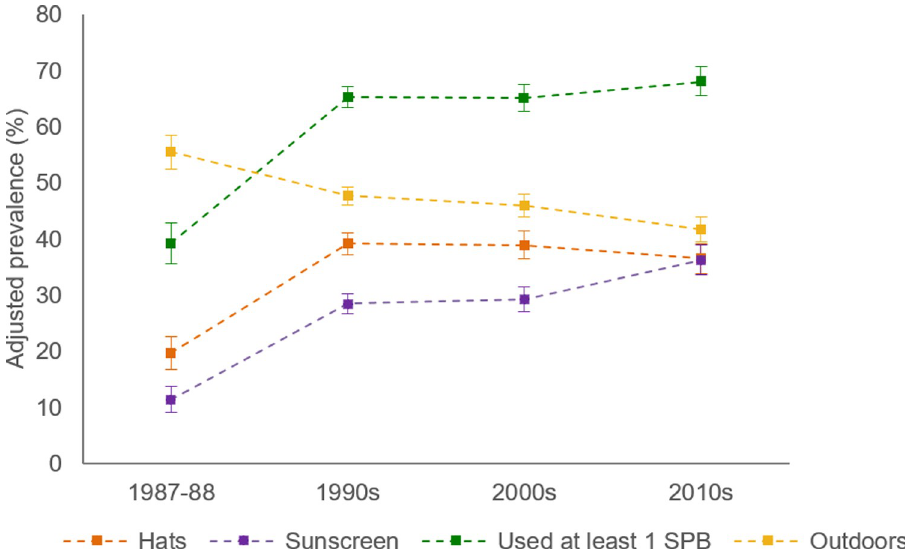
Fig 1. Adjusted prevalence of sun protection behaviours among Australian adults aged 18–69 years (1987–1988 to 2010s). Used at least 1 sun protection behaviour (SPB) defined as specifically used sunscreen or wore a hat or stayed mostly in the shade when outdoors during peak ultraviolet radiation hours on summer weekends. Data points represent cross-sectional samples from summers in each decade.